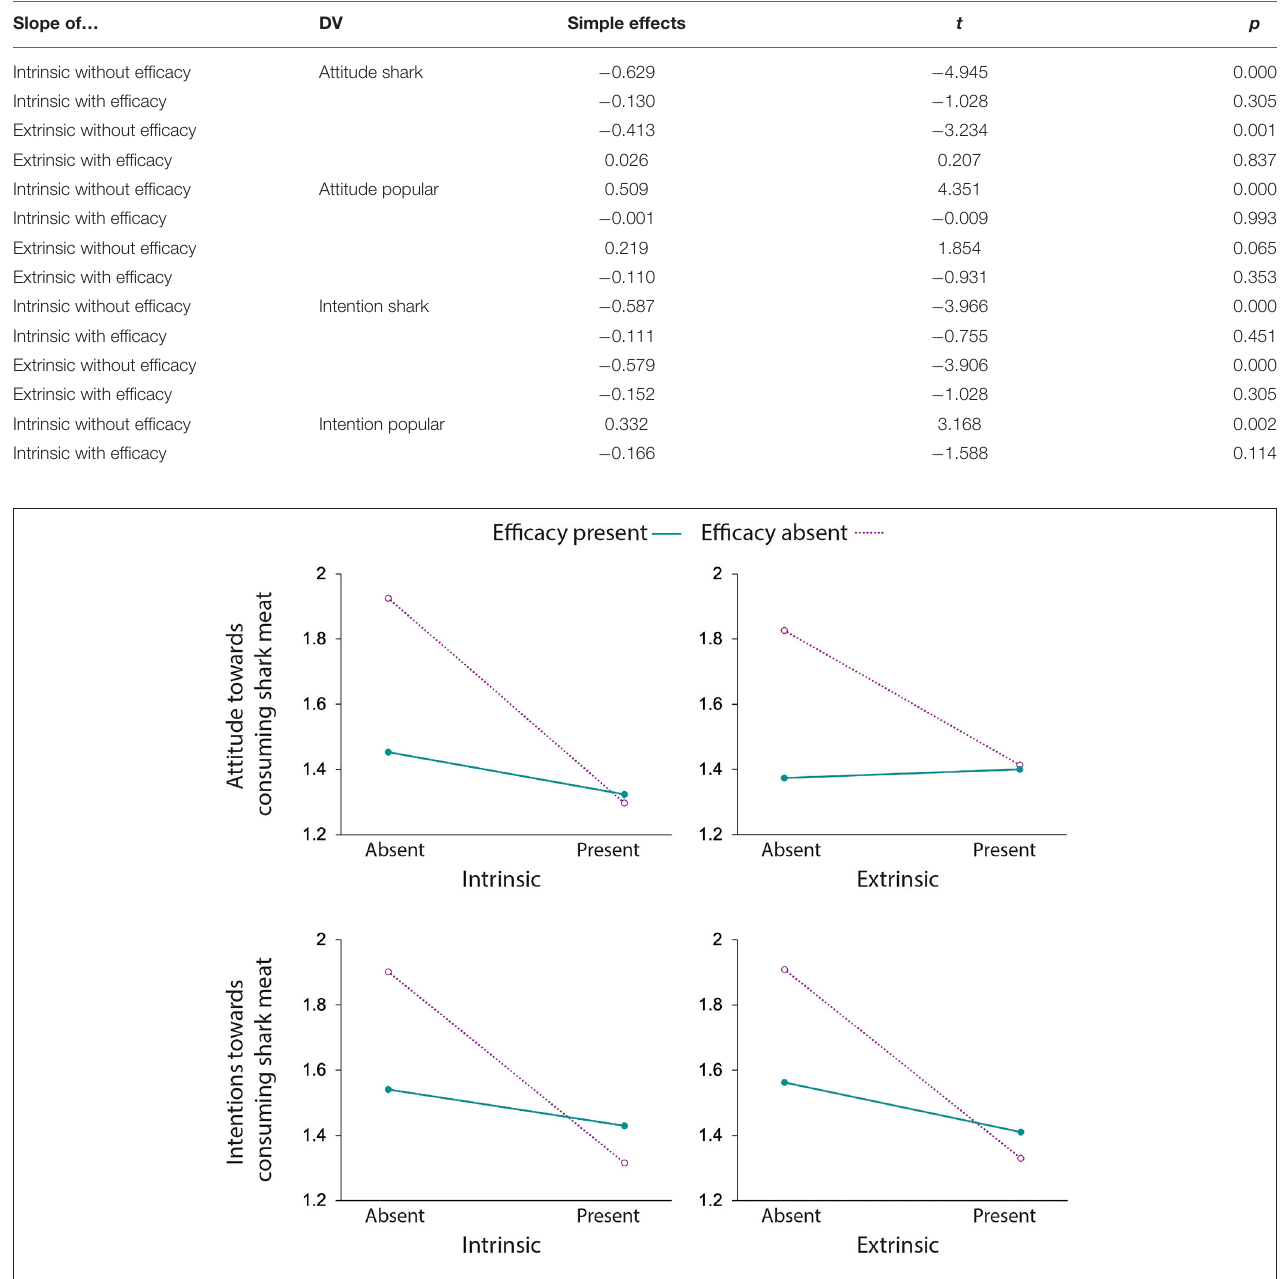
FIGURE 3 | Interactions between intrinsic and extrinsic risk messages and efficacy message on attitudes and intentions toward shark meat